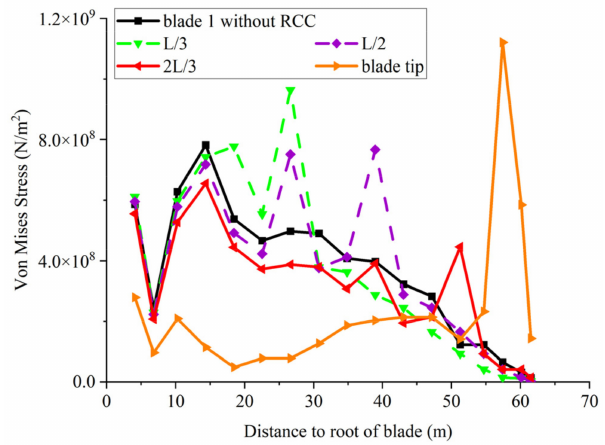
Figure 10. Comparison of stress distribution along the